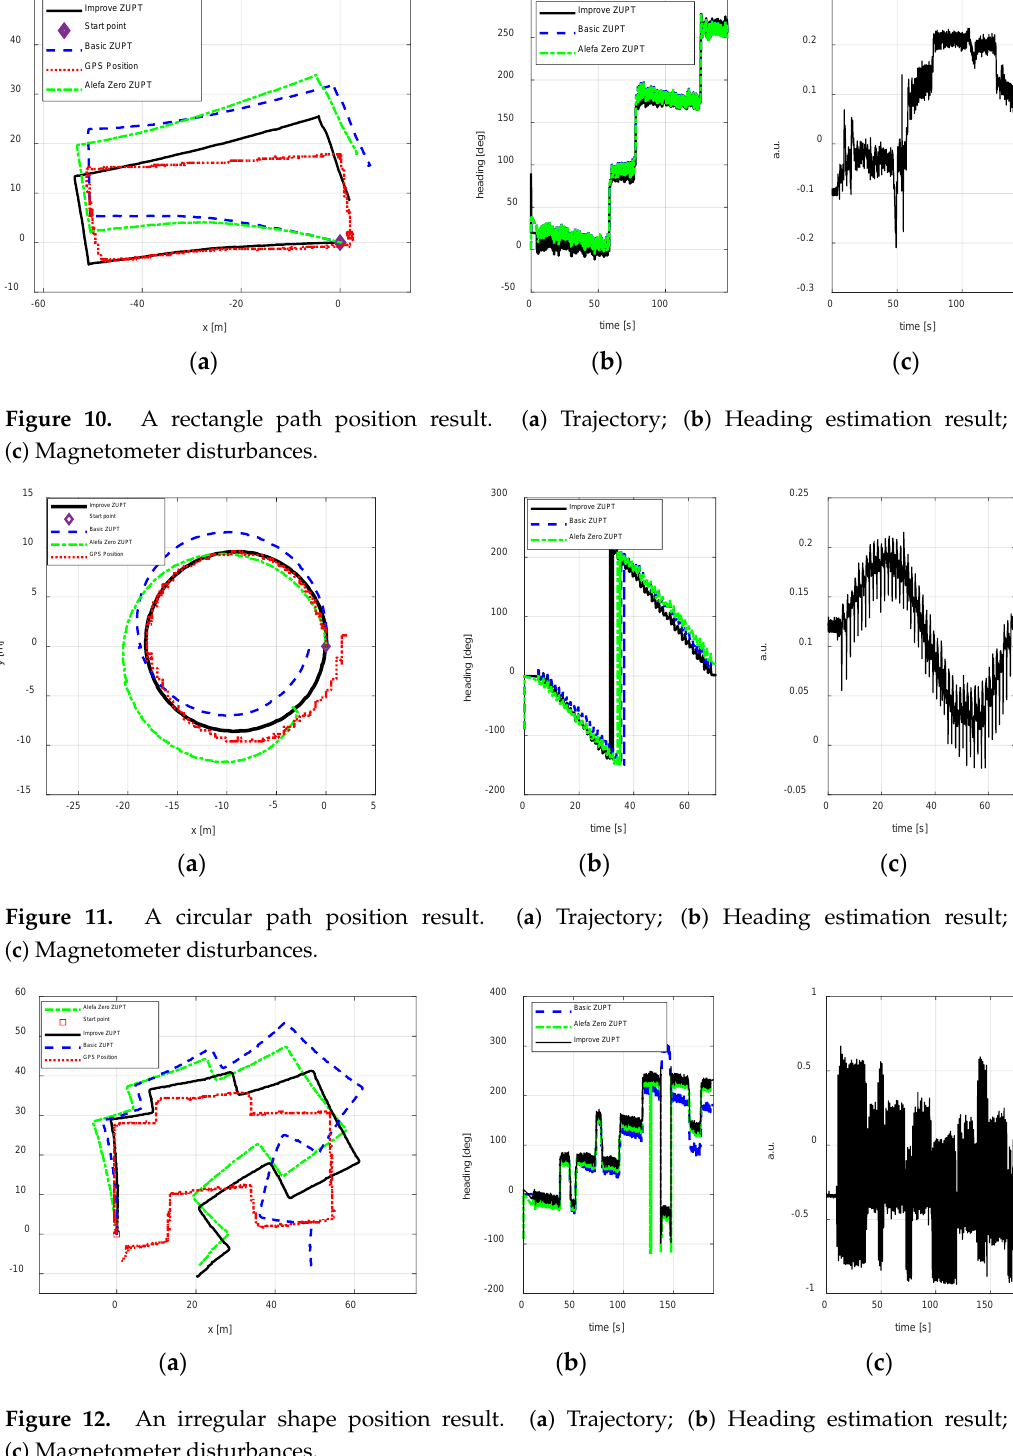
Figure 12. An irregular shape position result. ( a ) Trajectory; ( b ) Heading estimation result; ( c ) Magnetometer disturbances.